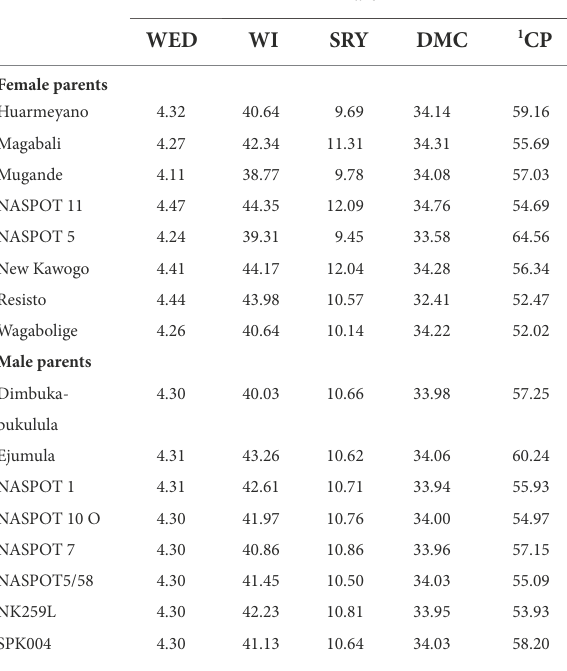
TABLE 6 General combining ability (GCA) predictions for weevil severity (WED, scale 1–9), weevil incidence (WI, %), storage root yield (SRY, t/ha), dry matter content (DMC, %), and number of emerged adult weevils (CP) for the 16 sweetpotato parental